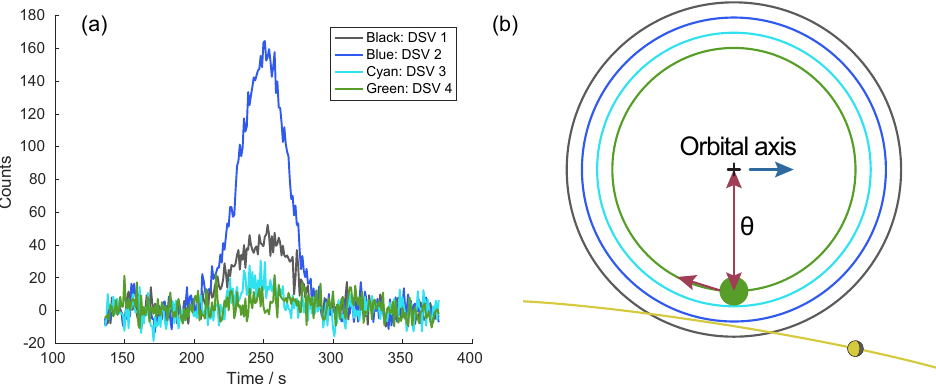
Figure 1. (a) Light curves of the Moon obtained from the four AMSU-B deep space views (pixels) on 2 November 2006. (b) Observing geometry projected to the sky: the axis of the orbit of the satellite is marked with a plus sign. θ = 9 . 5 ◦ is its angular distance from DSV 4, shown as a filled, green circle. The pointing direction of the instrument describes a great circle in the sky during one scan, which covers all four deep space views and then continues along the large, red arrow. From one scan to the next, all DSVs move by a small amount along the large circles in the orientation of the small red arrow. The yellow arrow gives an example of the trajectory of the Moon. DSV 2 came closest and thus gave the highest signal in its light curve. DSV 4 was too far away from the Moon to be affected by its presence. From the ratio of the maximum signals in DSV 1 and DSV 3 one can calculate how far the Moon is away from DSV 2. This distance is zero if and only if the counts from DSV 1 and DSV 3 are the same. The completion of the circles that each DSV describes in the sky takes 100min, the duration of the orbit of the satellite. This is fast compared to the movement of the Moon (synodic month 29.5 days) and the movement of the orbital axis of the satellite with a period of one year (blue